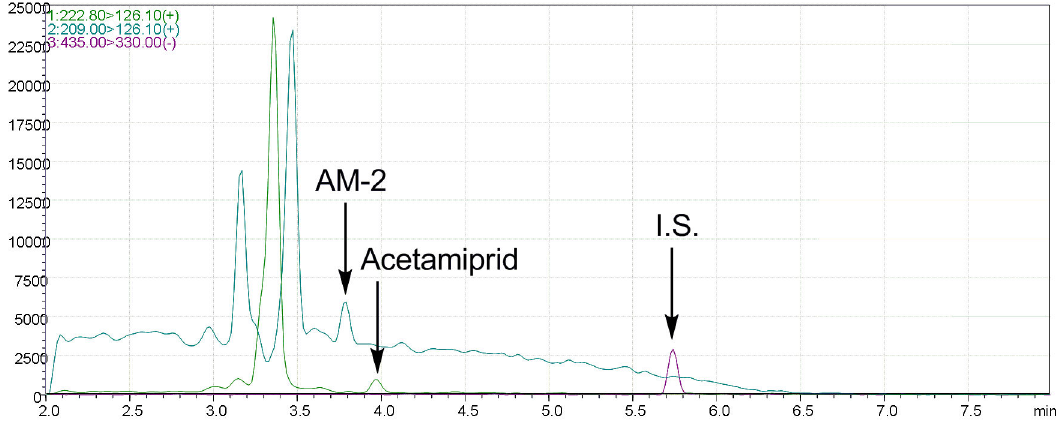
Figure 3. LC/MS/MS of the extract of standard urine solution containing acetamiprid (green), N -desmethyl-acetamiprid (AM-2) (blue) and internal standard (I.S.) (red).